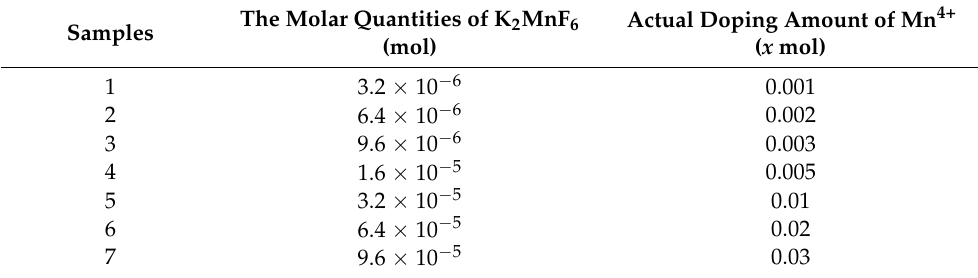
Table 1. Synthesis parameters of NNOF: x Mn 4+ phosphors with different doping amounts of Mn 4+ .